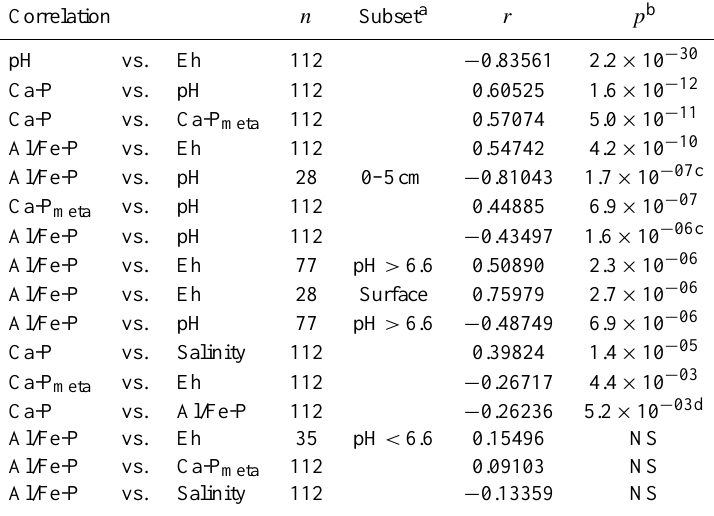
Table 1. Correlations between physical–chemical sediment characteristics and P fractions at P-enriched transects of the Firth of Thames, New Zealand.